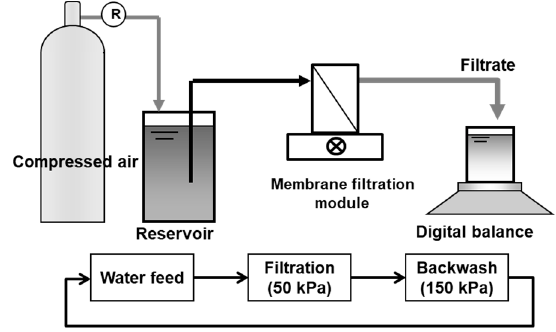
Figure 2. Schematic of the membrane filtration set-up and filtration